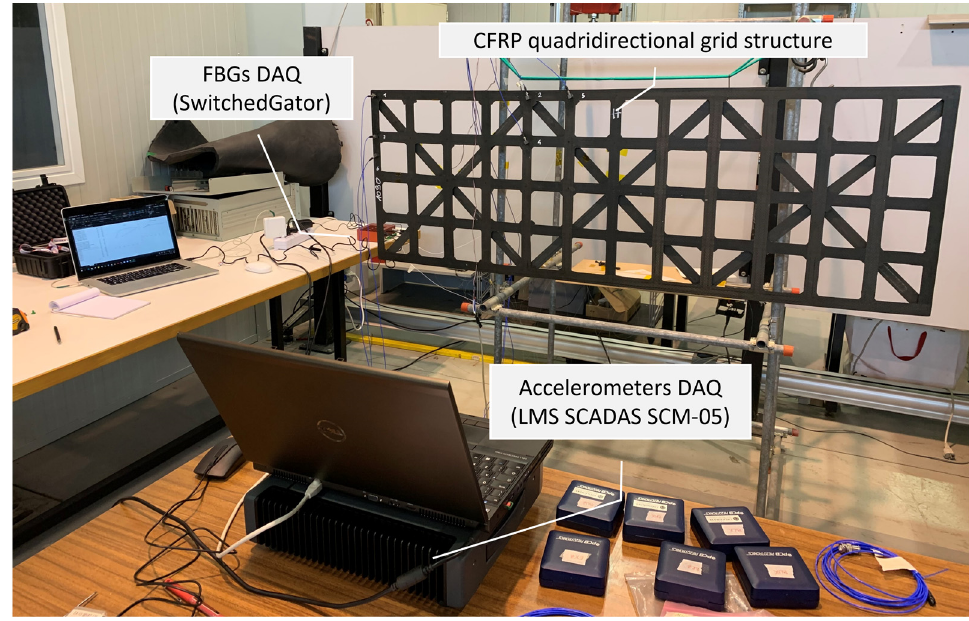
Figure 2. Experimental setup overview.